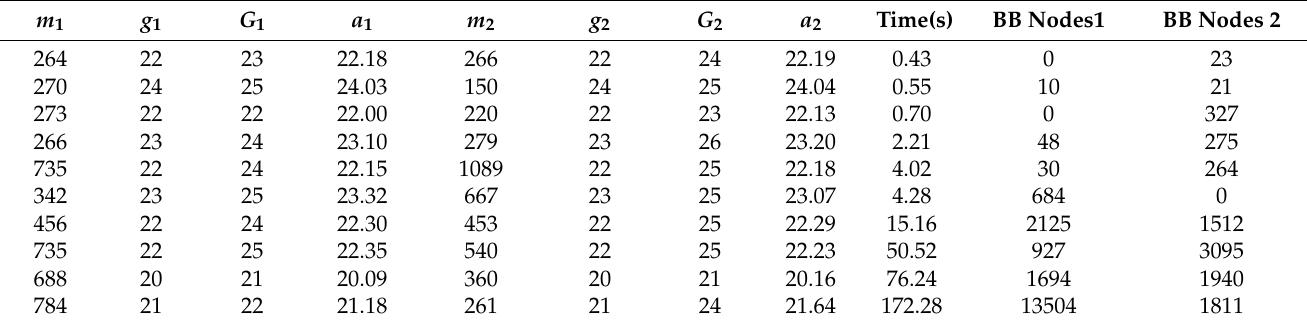
Table 3. Computational results for Pattern Equivalence—boosted